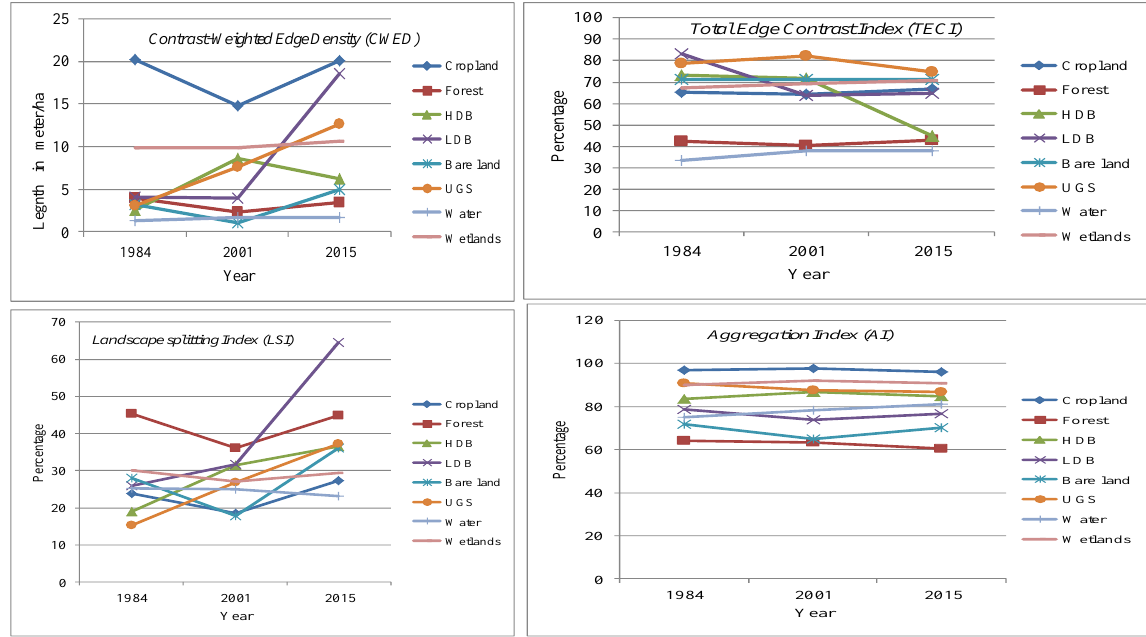
Figure 4: Evolution of landscape configuration